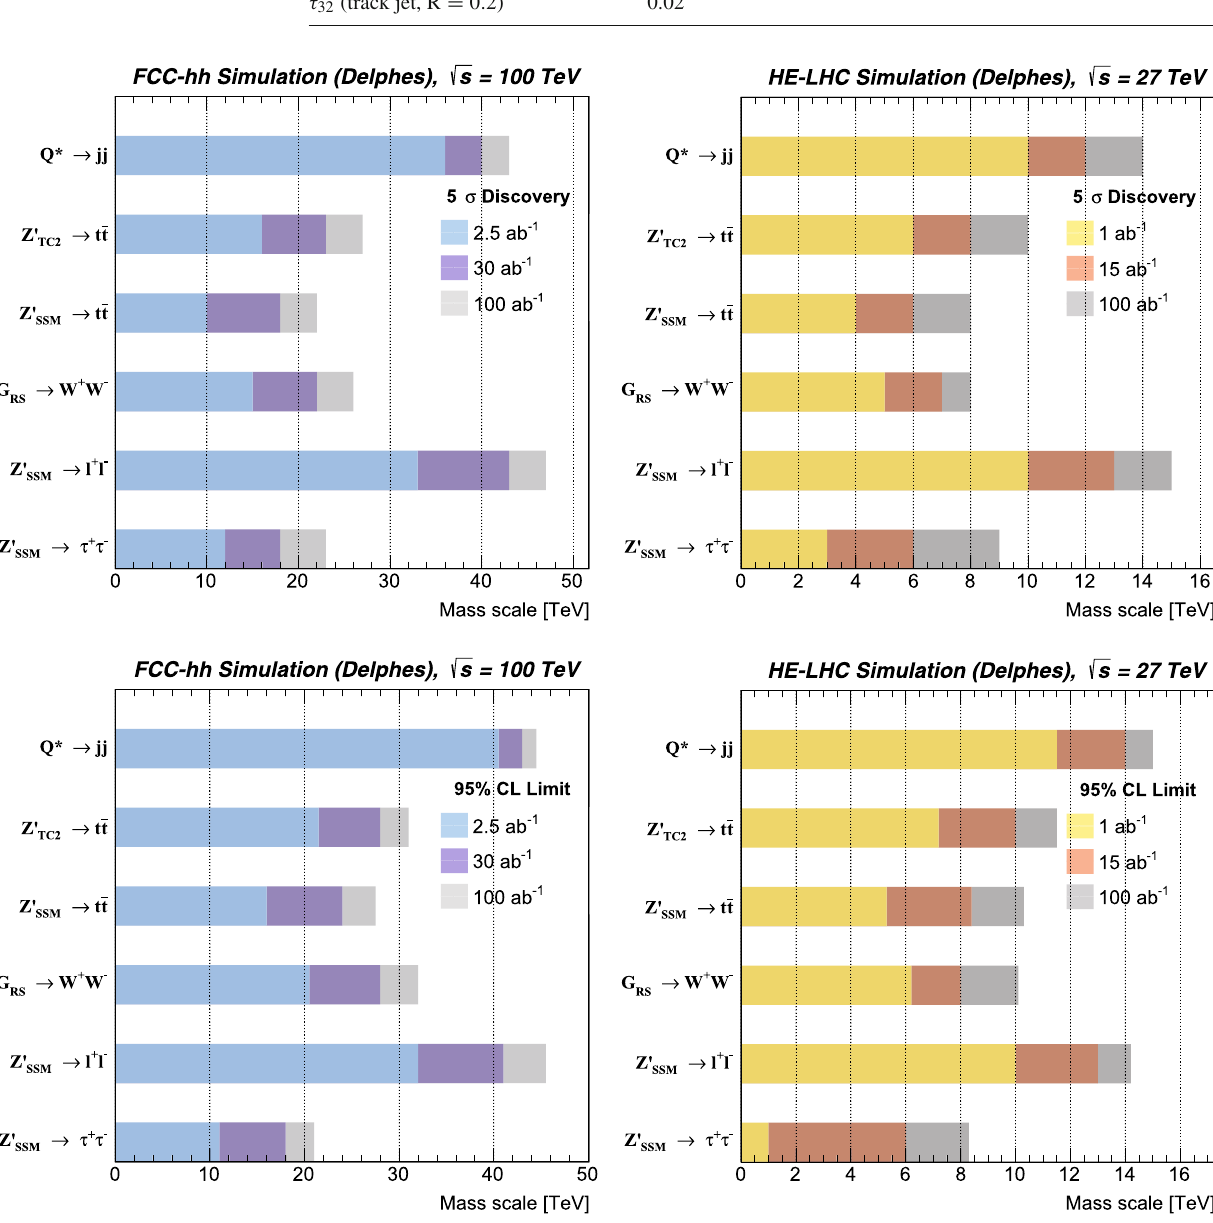
Fig. 16 Summary of a 5 σ discovery reach (top) and 95% CL limits (bottom) as a function of the resonance mass for different luminosity scenarios of FCC-hh (left) and HE-LHC